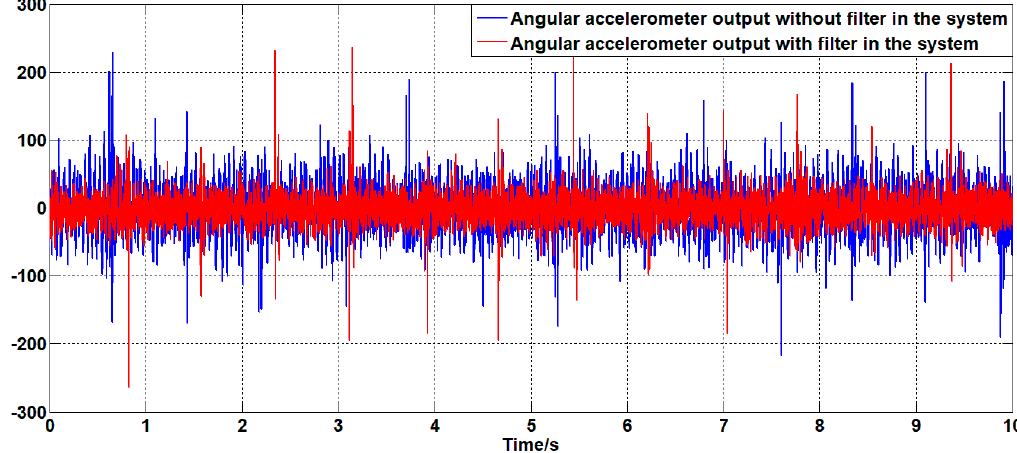
Figure 25. The angular acceleration curve of the system output with or without a filter.